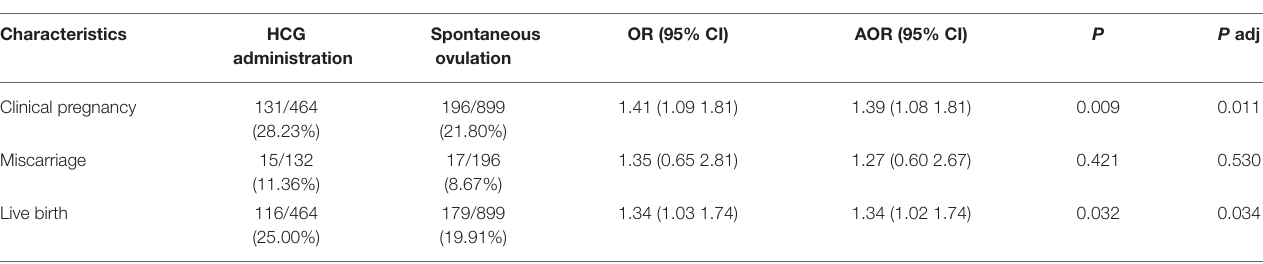
TABLE 3 | Reproductive outcomes of the single IUI group.